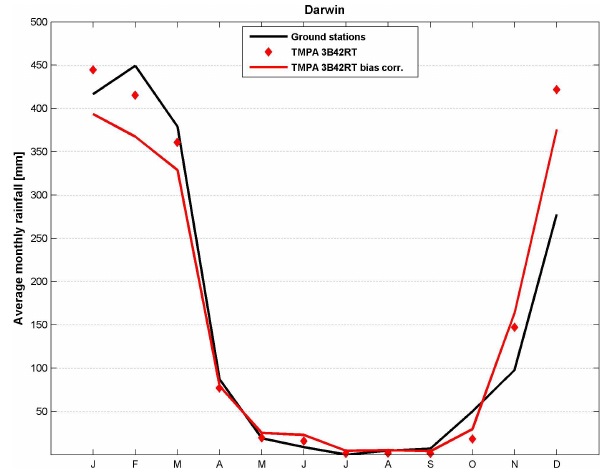
Fig. 9. Bias ratio vs. elevation for the individual ground stations in the six validation areas (R 2 = 0.0001, n = 73; of the 76 available stations (Table 1), 3 did not have any full year of validated observations).